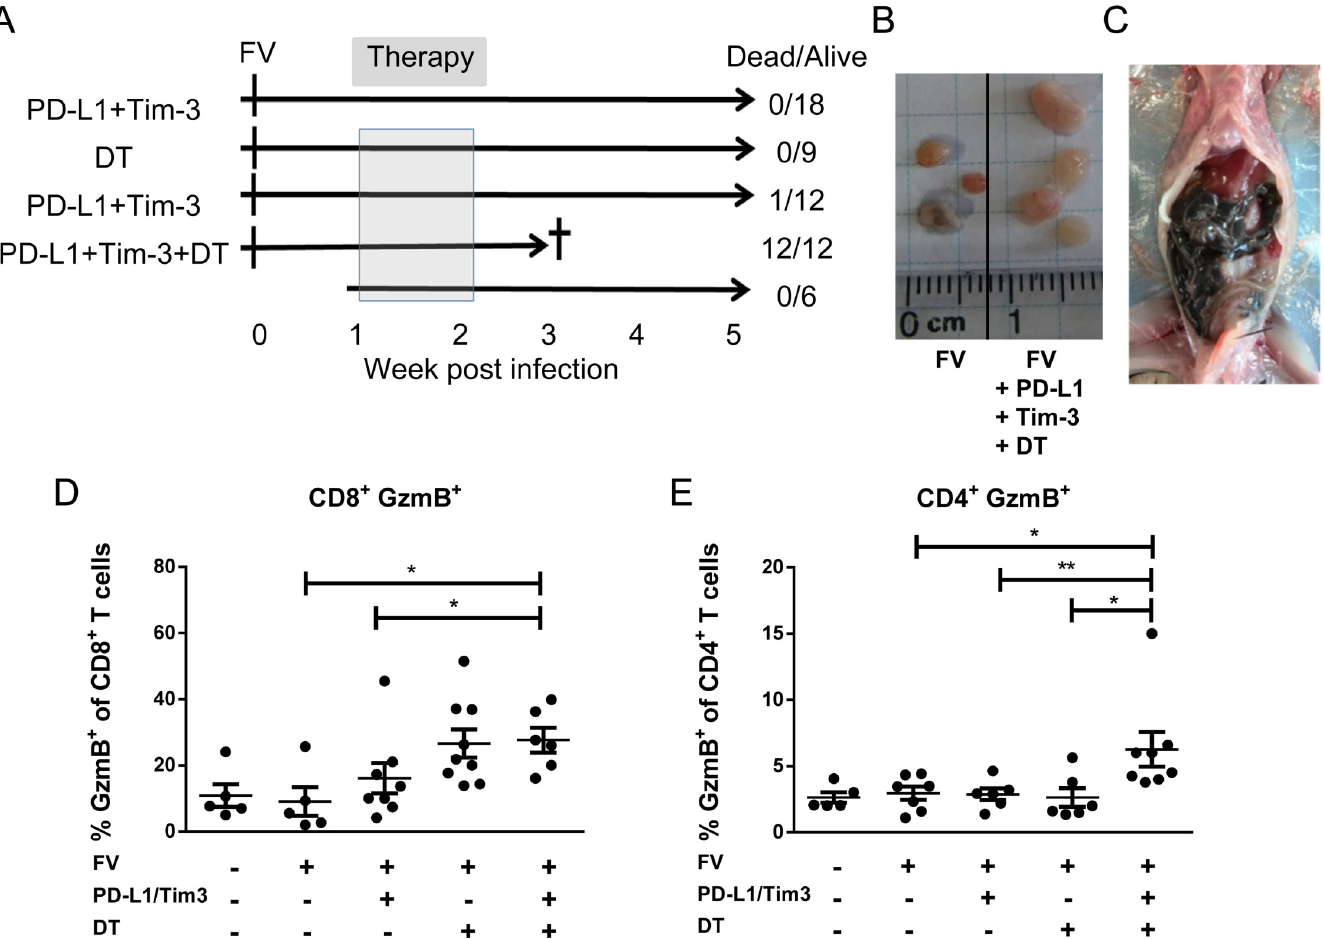
Fig 2. The death of FV infected mice within one week after Treg depletion and blocking of inhibitory pathways. DEREG mice were infected with FV and were treated with DT and/or blocking antibodies against PD-L1 and TIM-3 as indicated during the second week of infection ( A ). Lymphadenopathy ( B ) and pathology of the intestine ( C ) in mice after Treg depletion and treatment with anti-PD-L1 and anti-TIM-3. The percentages of CD8+GzmB+ ( D ) or CD4+GzmB+ ( E ) T cells isolated from the intestine of mice infected with FV and treated with DT and/or blocking antibodies against PD-L1 and TIM-3. Data were pooled from 3 to 5 independent experiments with similar results. Statistically significant differences are indicated by asterisks ( � < 0.05; �� < 0.005; one-way ANOVA with a Tukey